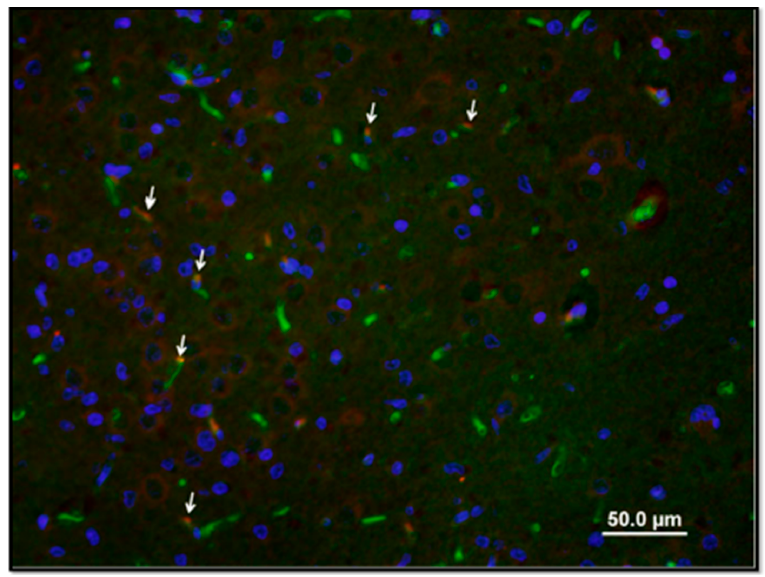
Figure 3. Representative image of immunostaining with ki-67 cell proliferation marker demonstrating the newly formed vessels (red) and merged images showing Isolectin-FITC (green) around the nucleus (blue), indicating a blood vessel. Note the nuclei co-localization with endothelial cells (arrows).